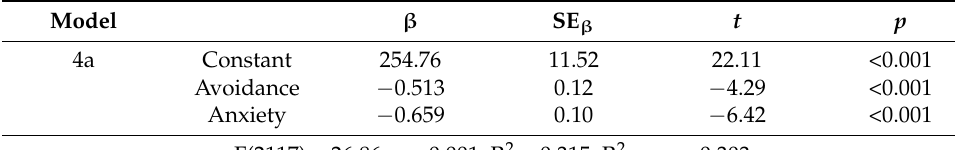
Table 7. Model for subgroup cases with low level of mindfulness. Model β